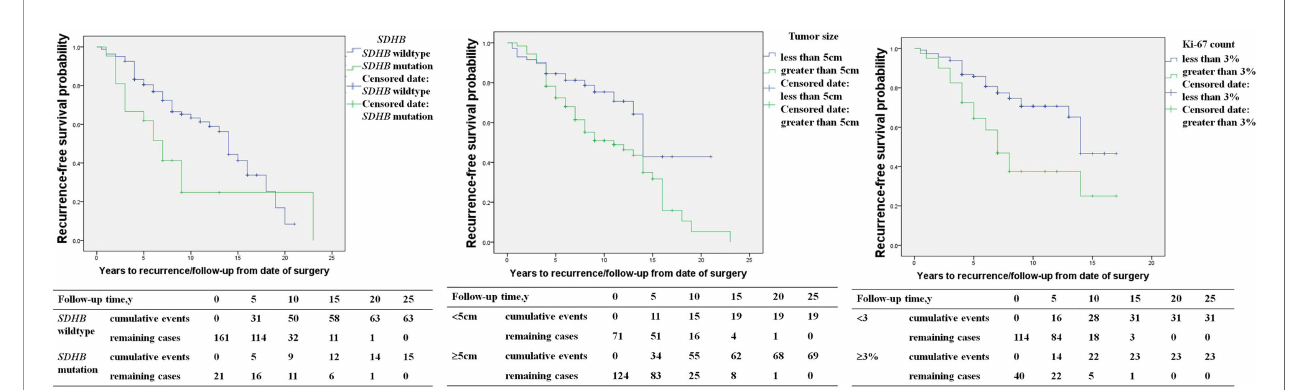
FIGURE 2 | The recurrence-free survival in pheochromocytoma/paraganglioma patients (SDHB mutation patients versus SDHB wildtype patients; primary tumor size <5 versus primary tumor size ≥ 5cm; average Ki-67 count <3% versus Ki-67 count ≥